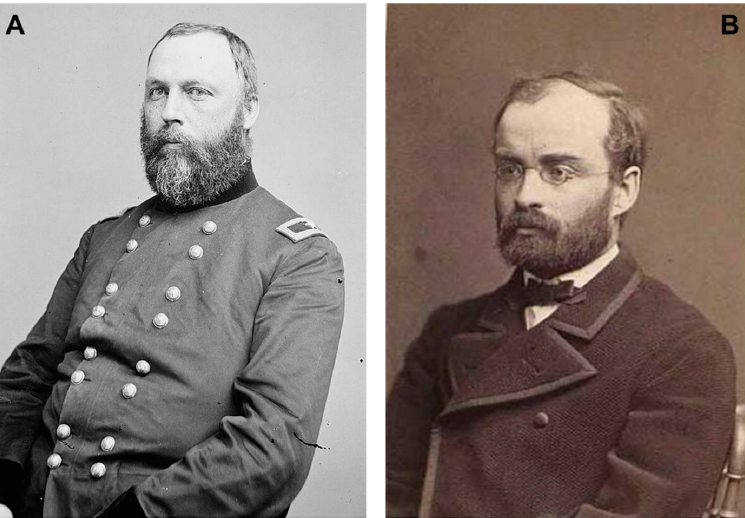
Figure 8. Pioneers in the use of lithium in the treatment of mental disorders: William Alexander